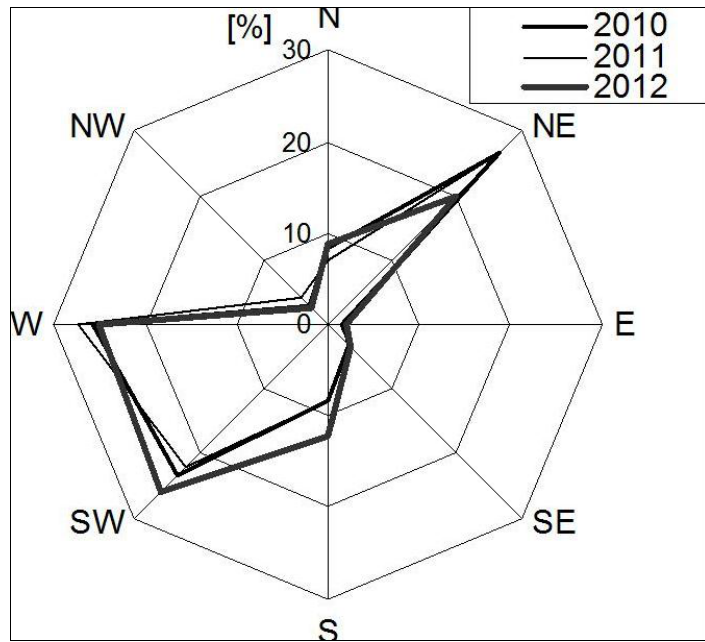
Fig. 5. Wind rose for the Goczałkowice station in